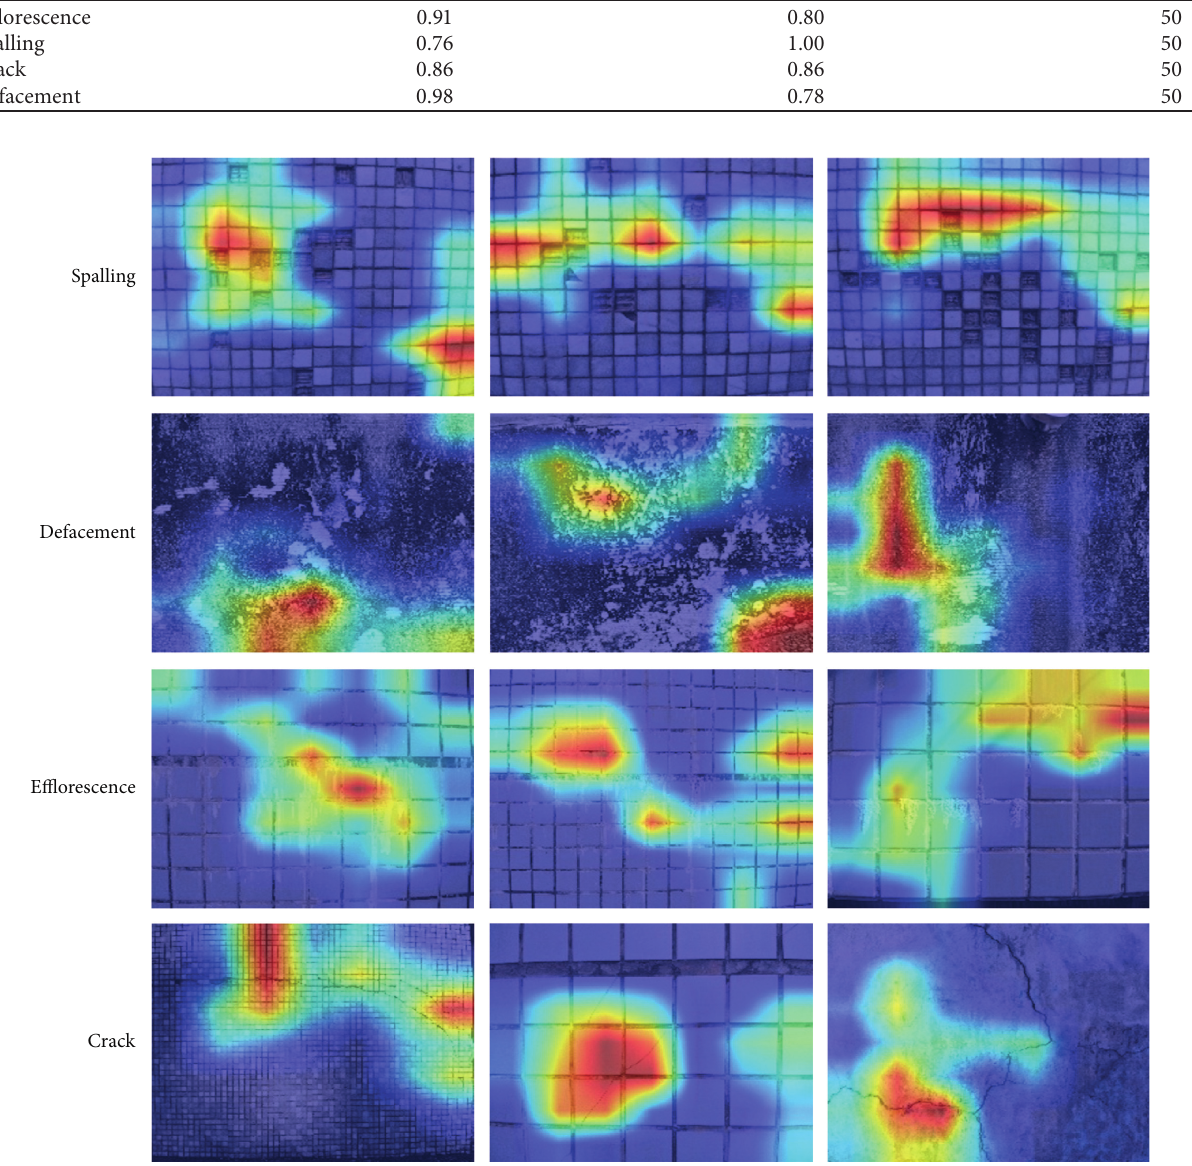
Figure 4: Correct localization. Table 2: Confusion